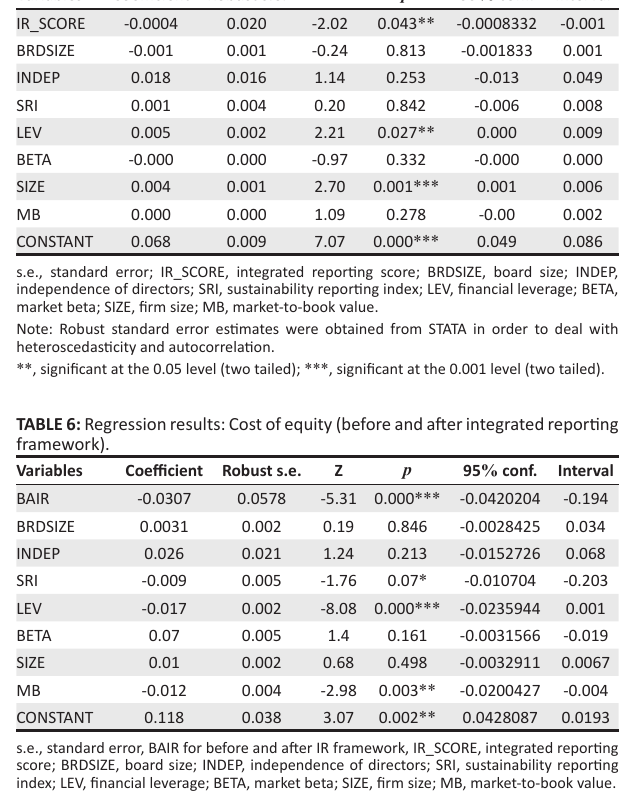
TABLE 5: Regression results: Cost of equity. Variables Coefficient Robust s.e.